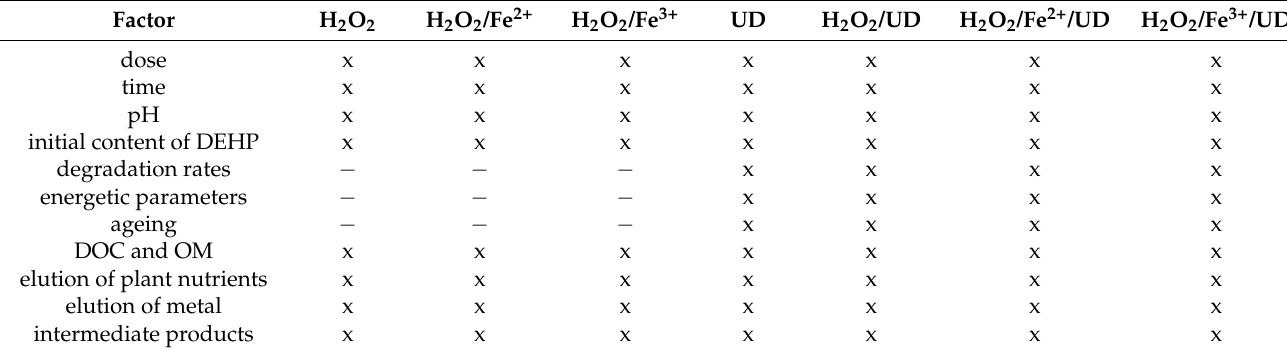
Table 1. Investigated factors in tested